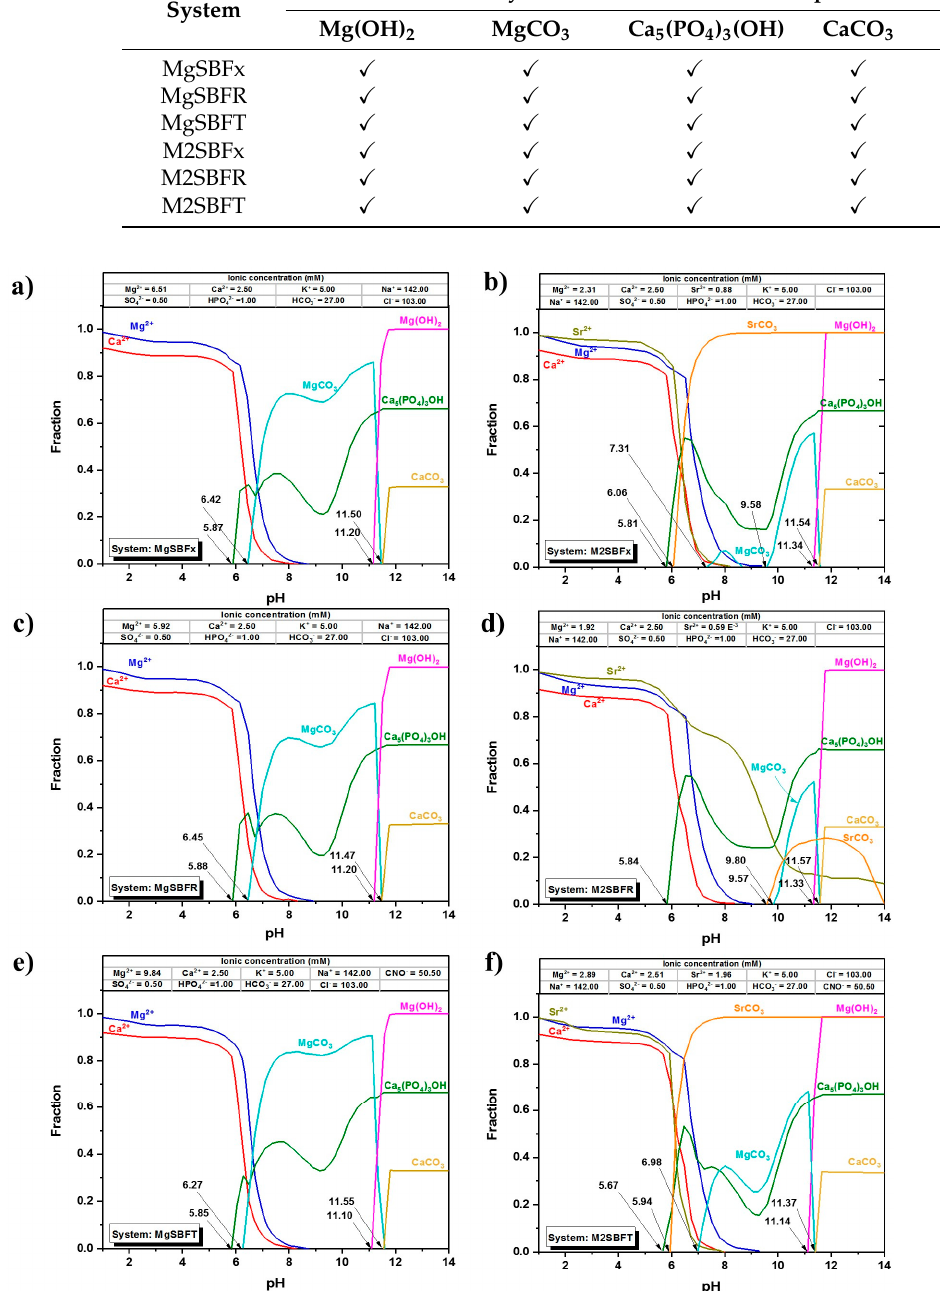
Table 6. Summary of possible precipitate predictions via Hydra–Medusa software. System